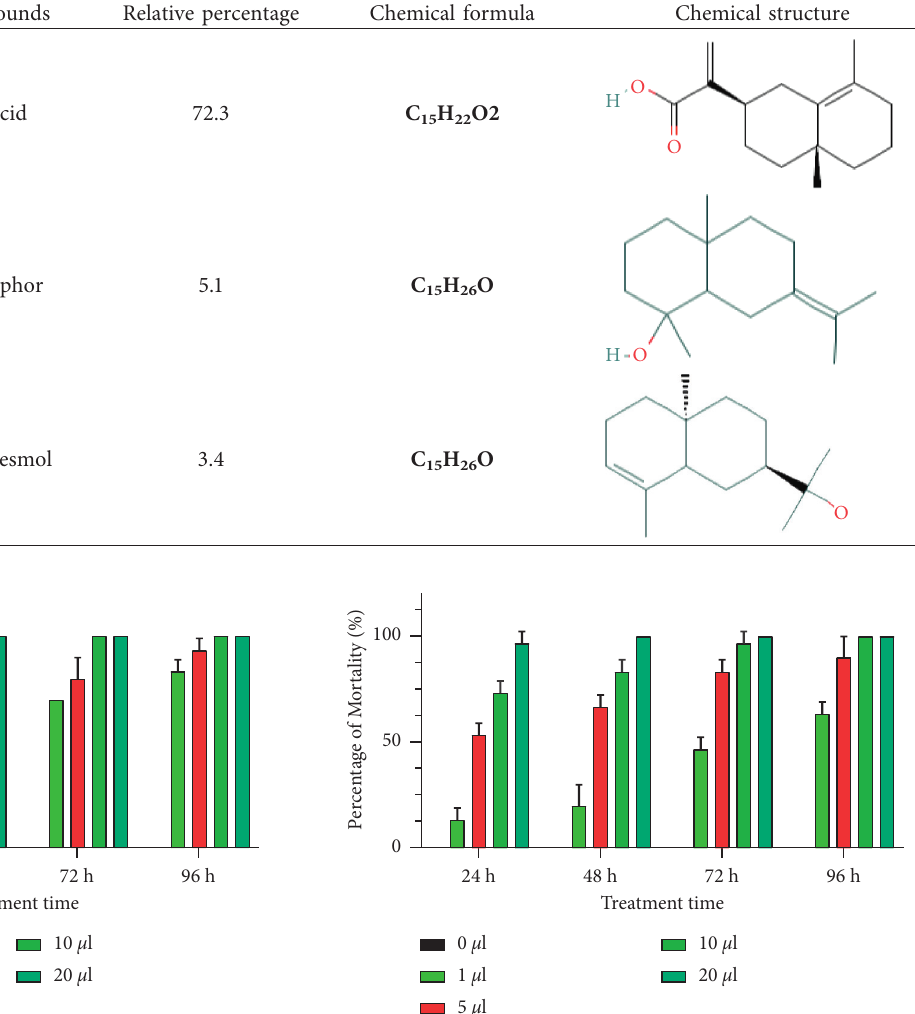
Figure 5: Mortality rate of Callosobruchus maculatus Fab. adults exposed to the inhalation test of Artemisia herba alba L. essential oils.